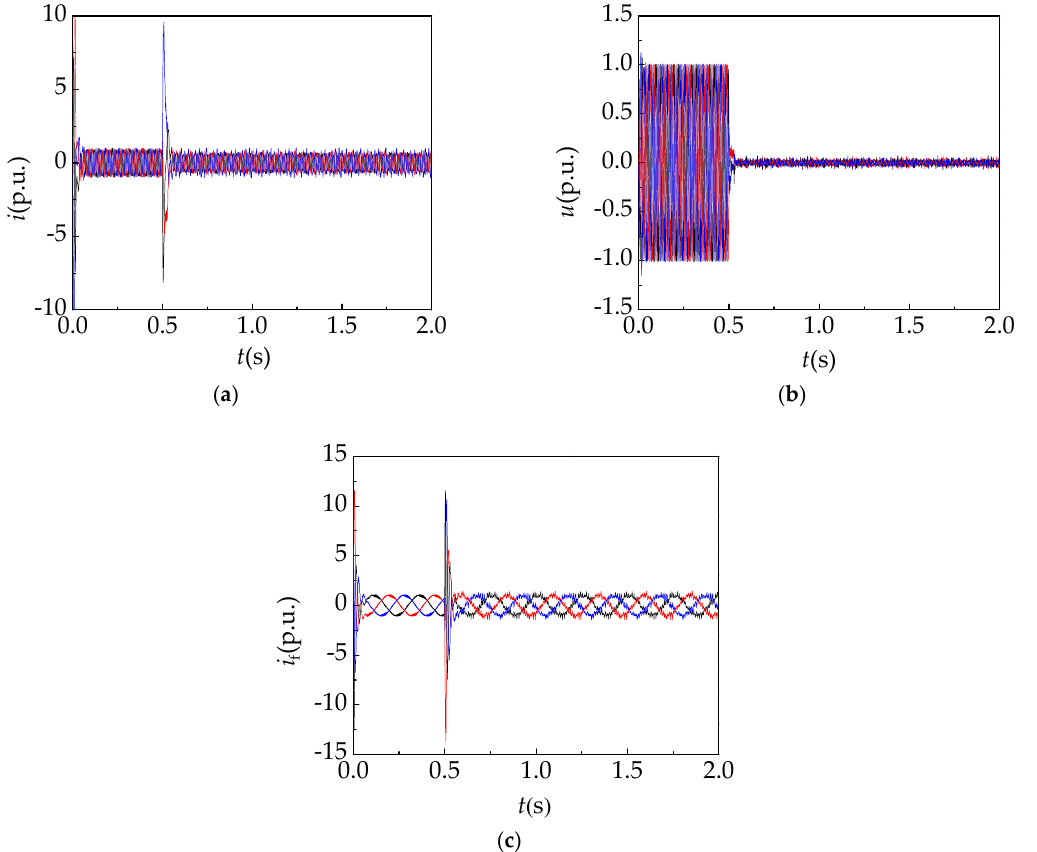
Figure 12. The waveforms of electrical quantities after the stator three phase short-circuit fault in the subsynchronous operation state when s is 0.08: ( a ) Stator current; ( b ) stator induced voltage; ( c ) rotor current.